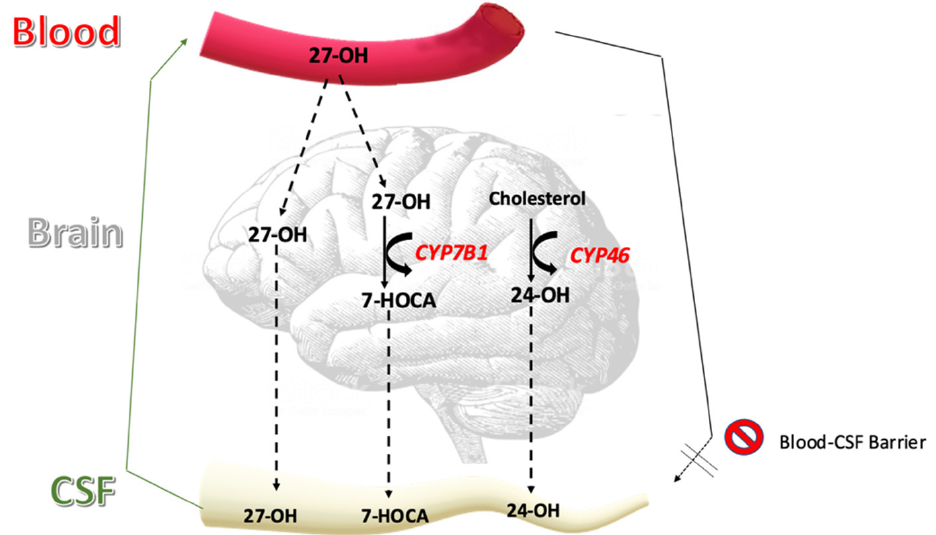
Figure 1. Flux of oxysterols into the cerebrospinal